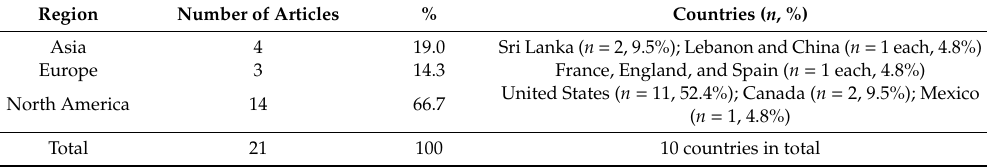
Table 4. Regional distribution of the articles considered in the present